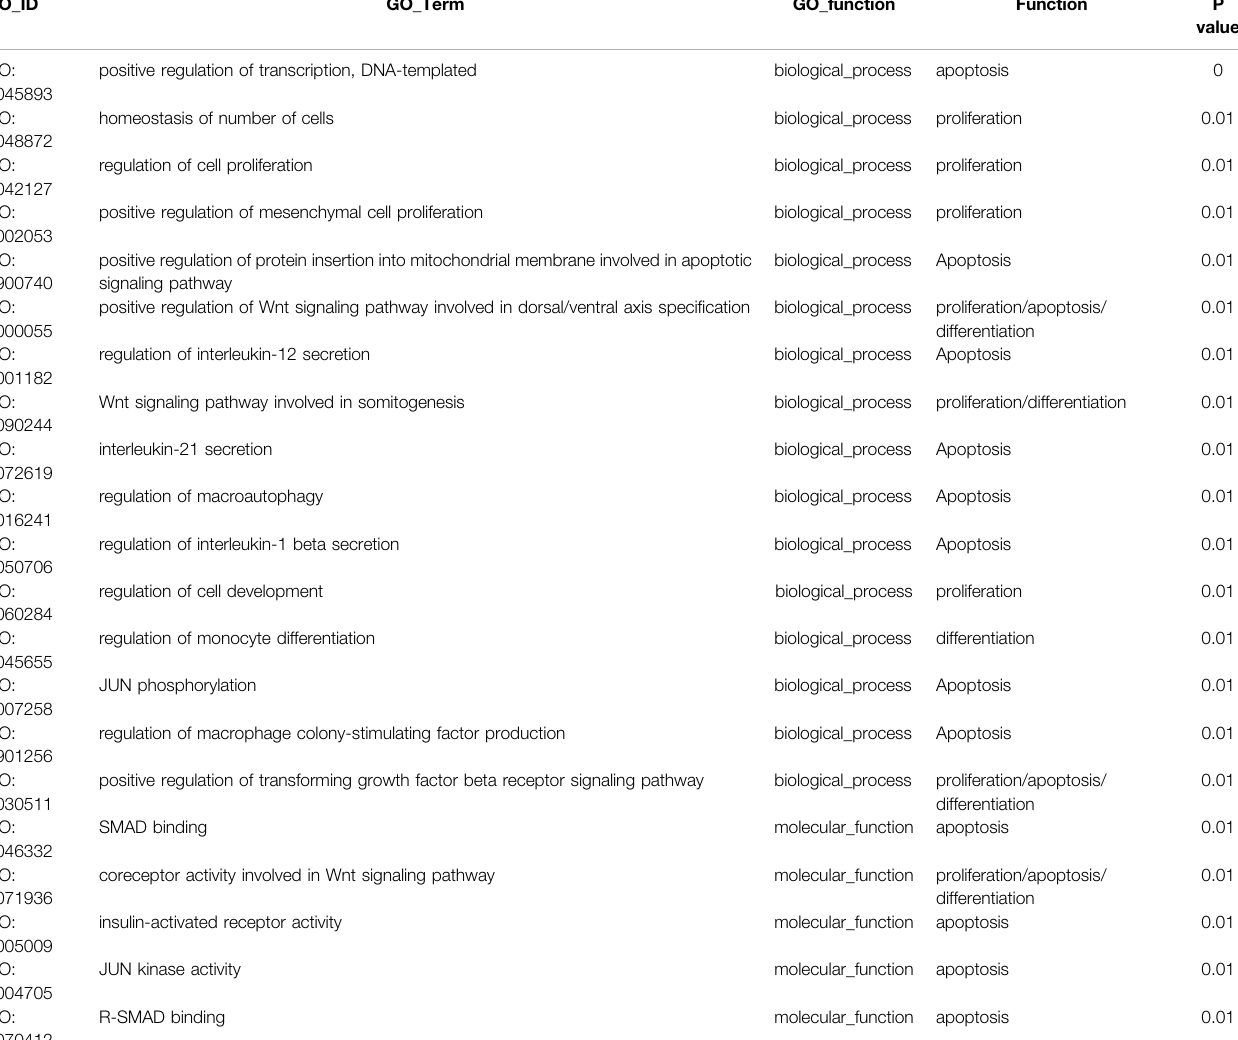
TABLE 3 | GO terms of DEcircRNAs related to adipose tissue aging (apoptosis, proliferation and